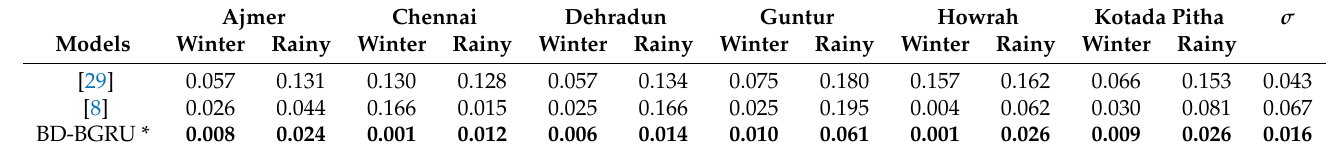
Table 9. The forecasting performance of BD-BGRU compared to the benchmark